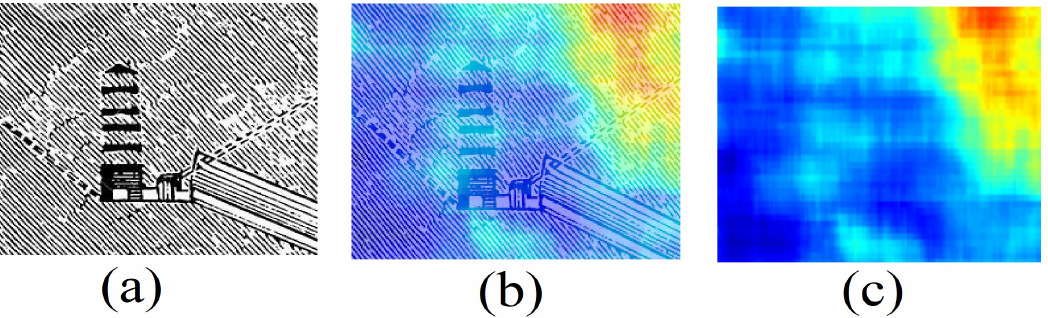
Figure 24. ( a ): Tomographic map of Khnum-Khufu overlapped to its schematic representation. ( b ): Tomographic map of Khnum-Khufu.